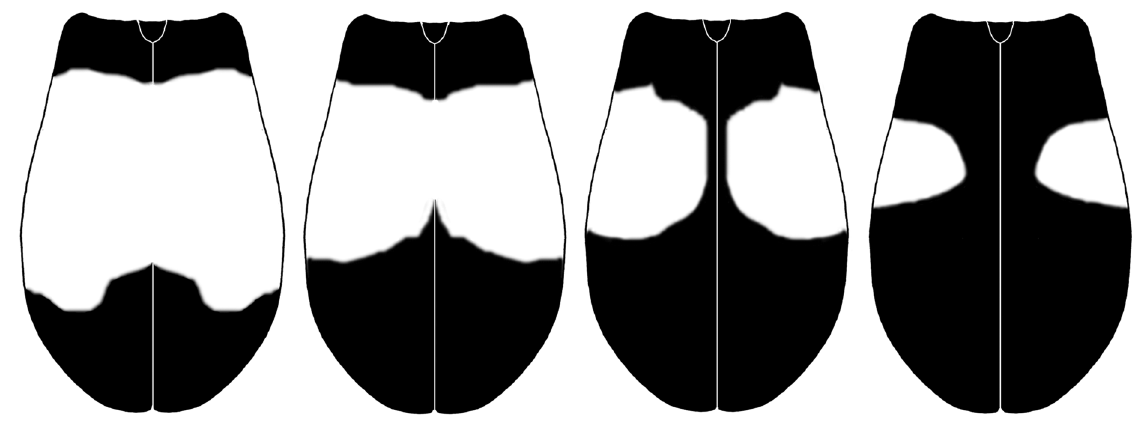
Fig. 3. Elytral pattern variation of Intybia histrio (Kiesenwetter,